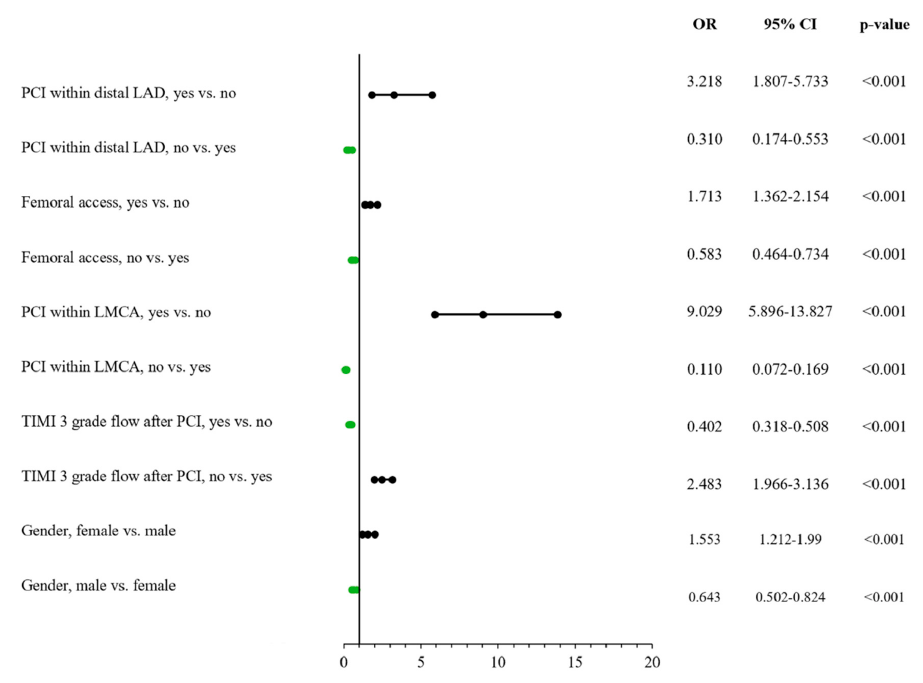
Figure 3. Risk factors for periprocedural complications. LAD: left anterior descendent artery; LMCA: left main coronary artery; PCI: percutaneous coronary intervention; TIMI: Thrombolysis I = in Myocardial Infarction.